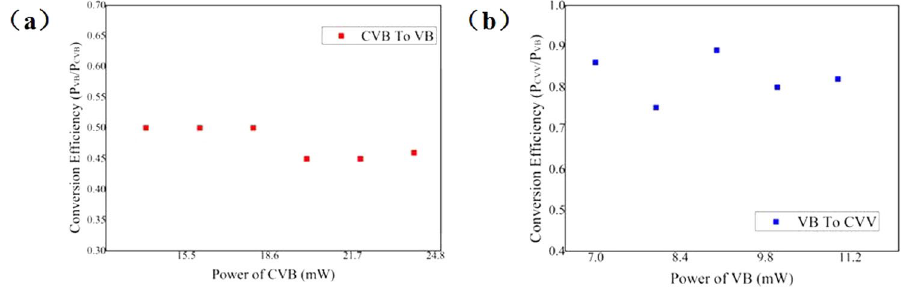
Figure 12. The experimental conversion efficiencies of CVB to VB and VB to CVV beam. ( a ) The conversion efficiency of CVB to VB (the ratios of the VB’s power P VB to the CVB’s power P CVB ). ( b ) The conversion efficiency of VB to CVV beam (the ratios of the CVV’s power P CVV to the VB’s power P VB